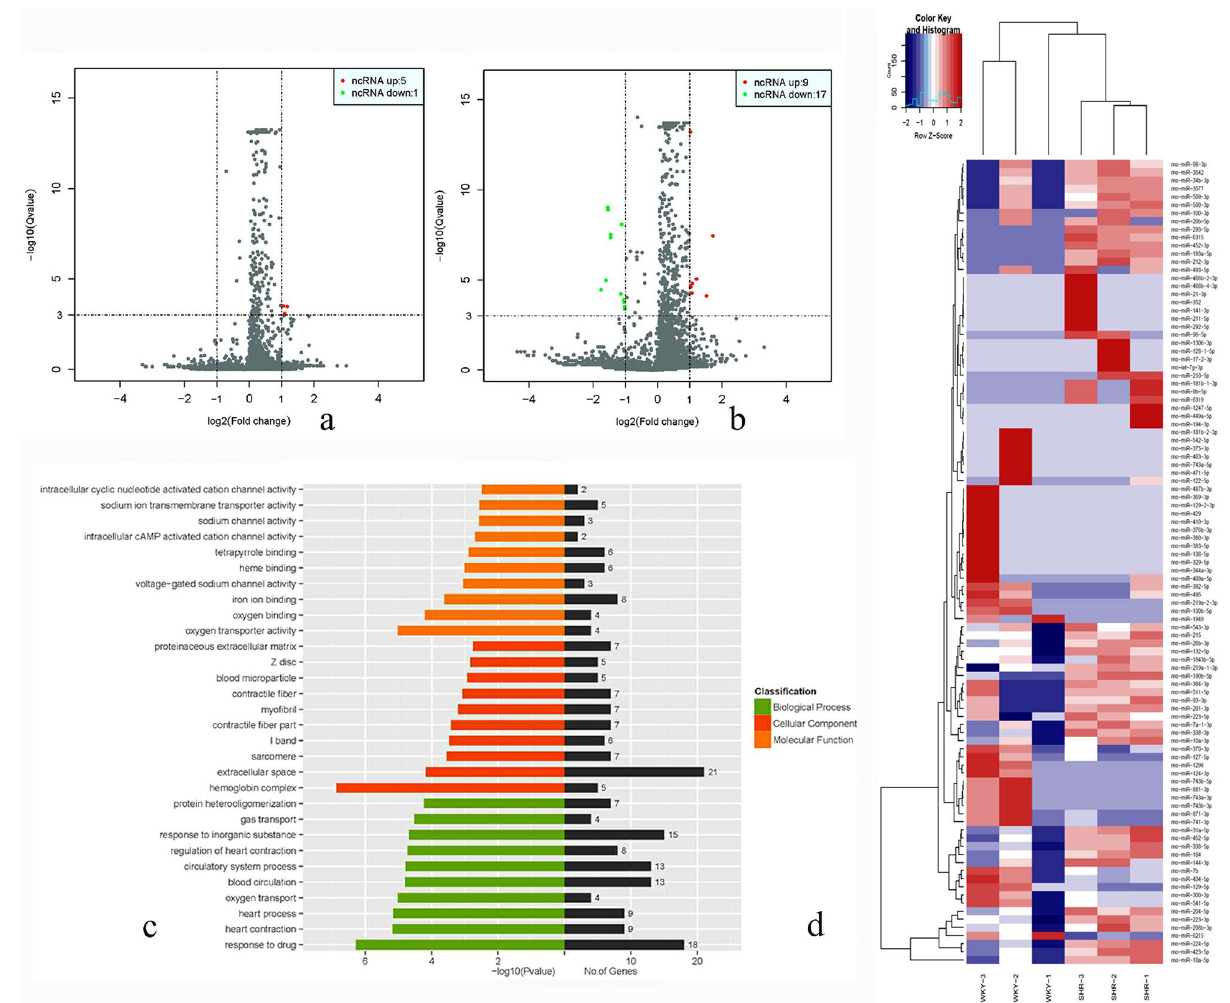
Figure 3. Effects of amiodarone on genes and lncRNAs expression. ( a ) Volcano plots of SHR group in arrhythmia treated with amiodarone. ( b ) Volcano plots of WKY group with arrhythmia treated with amiodarone. ( c ) GO analysis diagram for comparison of lncRNAs before and after amiodarone treatment in SHR group, green parts indicated biological processes and the red represented cellular components, and the yellow represented molecular functions. In addition, the black represented the number of related genes. ( d ) The cluster diagram of differential gene expression patterns. Column and row respectively represents experimental samples and the degree of gene expression in different samples: red means a relatively high expression and navy blue means low expression level. The sample tree on the top represents the similarity clustering relationship among the samples and the gene tree on the left represents the expression-similarity clustering relationship between genes 22